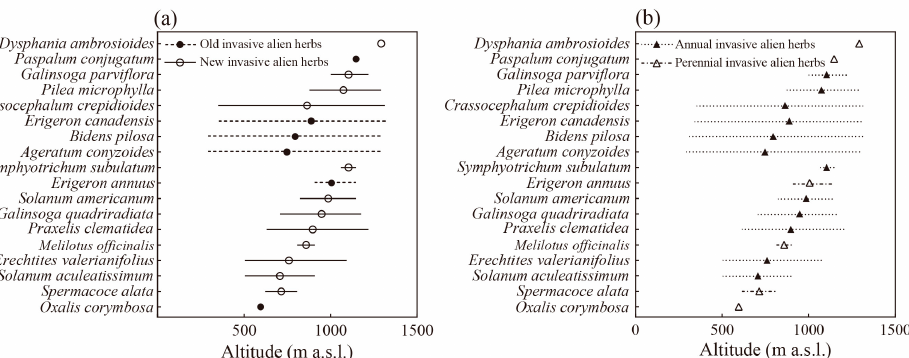
Figure 3. The altitudinal distribution range of ( a ) new and old invasive alien herbs and ( b ) annual and perennial invasive alien herbs. Old and new invasive alien herbs are indicated by dashed and solid lines, respectively. Annual and perennial invasive alien herbs are indicated by dotted lines and dot-dash lines, respectively. The positions of the symbols show the average altitudes at which the species occurs. Solid and hollow circles denote old and new invasive alien herbs, respectively. Solid and hollow triangles indicate annual and perennial invasive alien herbs, respectively.